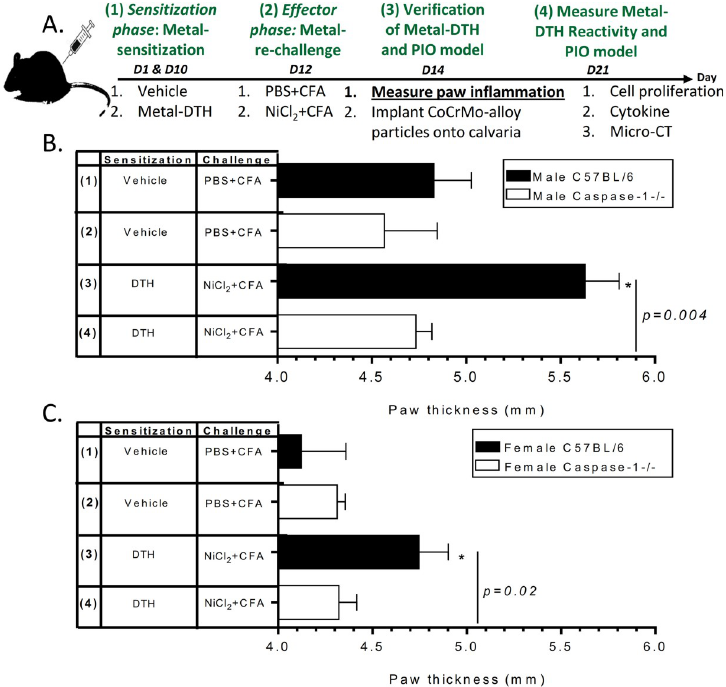
Fig 1. Inflammasome deficient mice are resistant to developing DTH responses to implant metals as determined by paw inflammation to metal challenge. (A) Schematic model for generating metal-DTH to implant metal(s) and particle-induced osteolysis in vivo over 21 days. Metal-DTH responses were determined by measuring paw thickness/ inflammation 48 h post challenge on day 14 in both (B) male and (C) female C57BL/6 and Caspase-1-/- mice aged 12– 16 weeks that were either non-sensitized (vehicle group) or metal-sensitized (DTH group). Data represent two independent experiments with n = 4–5 mice/group in each experiment. Paw inflammation is represented as the mean ± SEM. Statistical significance was determined by unpaired Mann-Whitney test and asterisk ( � ) denote significant differences at p < 0.05 compared to respective vehicle